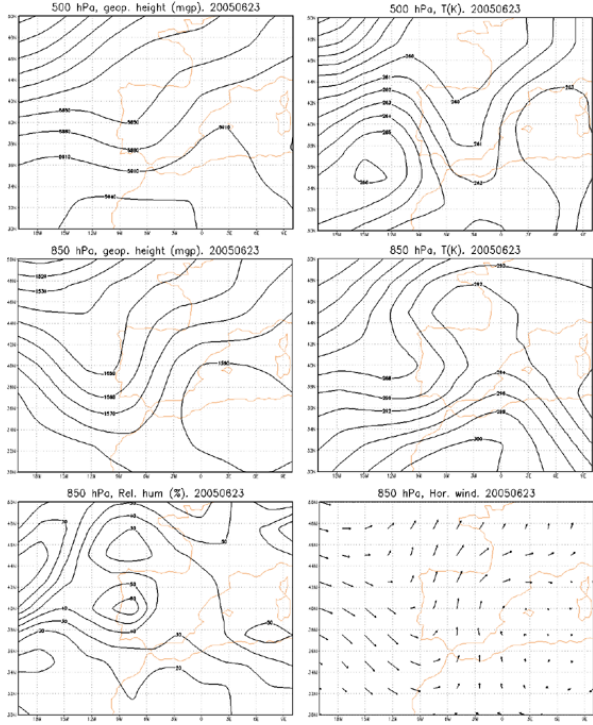
Fig. 14. NCEP reanalysis, 12:00UTC. Date: 2 July 2001, CL5. The atmospheric fields shown are: φ 500 (gpm), T 500 (K), φ 850 (gpm), T 850 (K), rh 850 (%) and wind direction at 850hPa, from left to right.